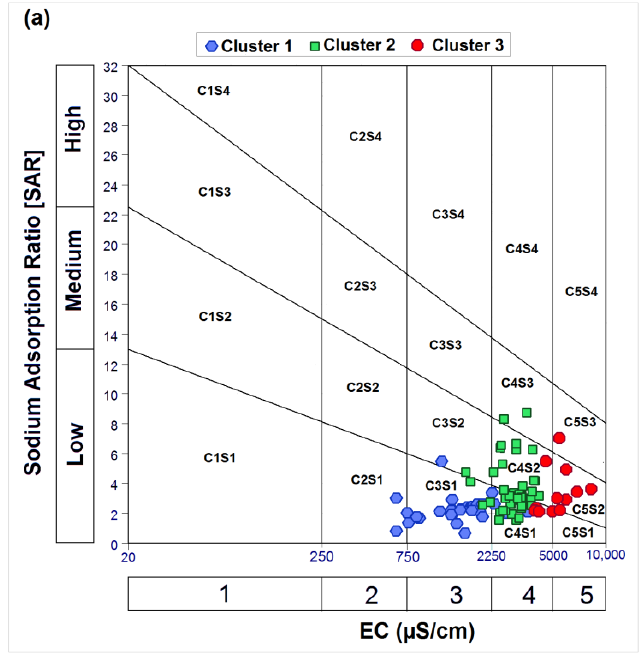
Figure 10. Saturated index of: ( a ) carbonates minerals; ( b ) Gypsum-Anyhydride; ( c ) Halite. Table 3. Summary of minerals Saturation Index ( SI ) in groundwater using PHREEQC.